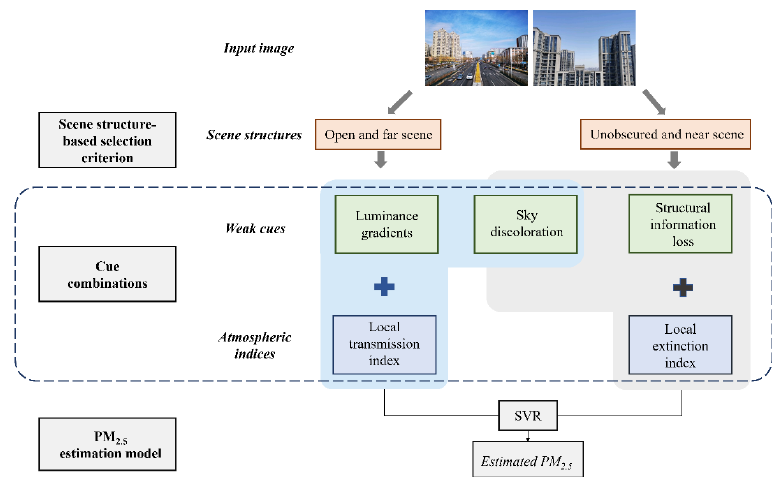
Figure 1. Workflow of the proposed PM 2.5 concentration estimation framework.